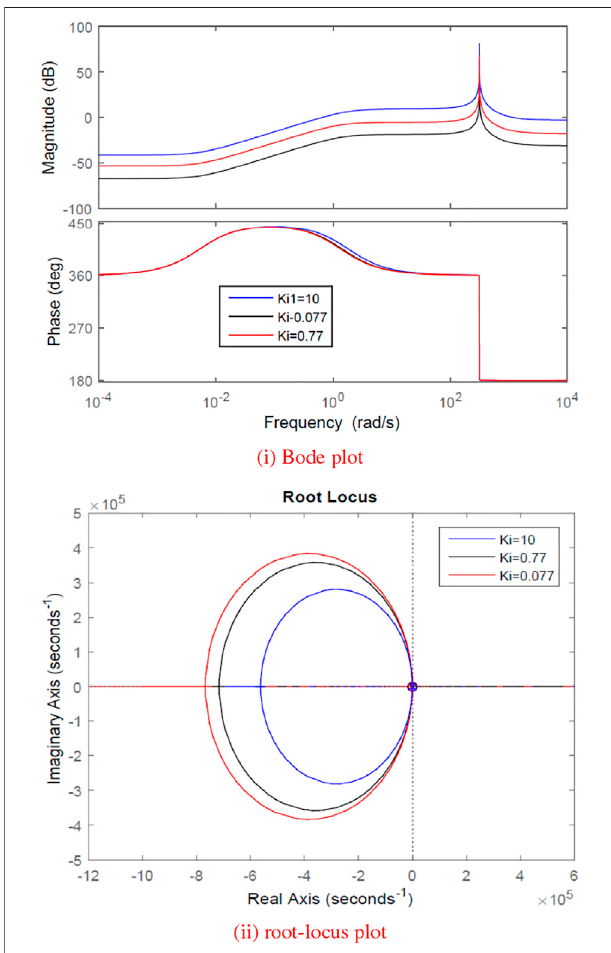
FIGURE 5 | Gov(s) plots for different integral constants. (i) Bode plot. (ii) Root-Locus plot.